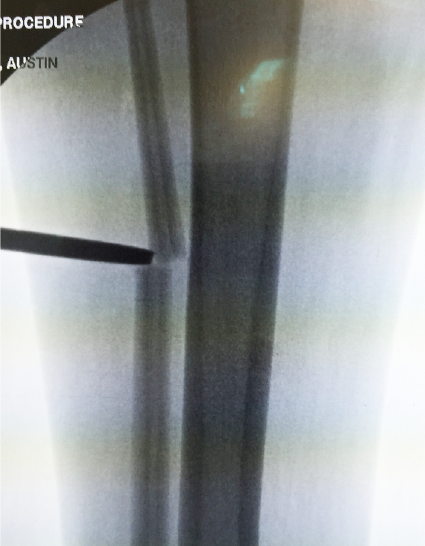
Figure 13. The osteotome is inserted through a limited incision under fluoroscopy.